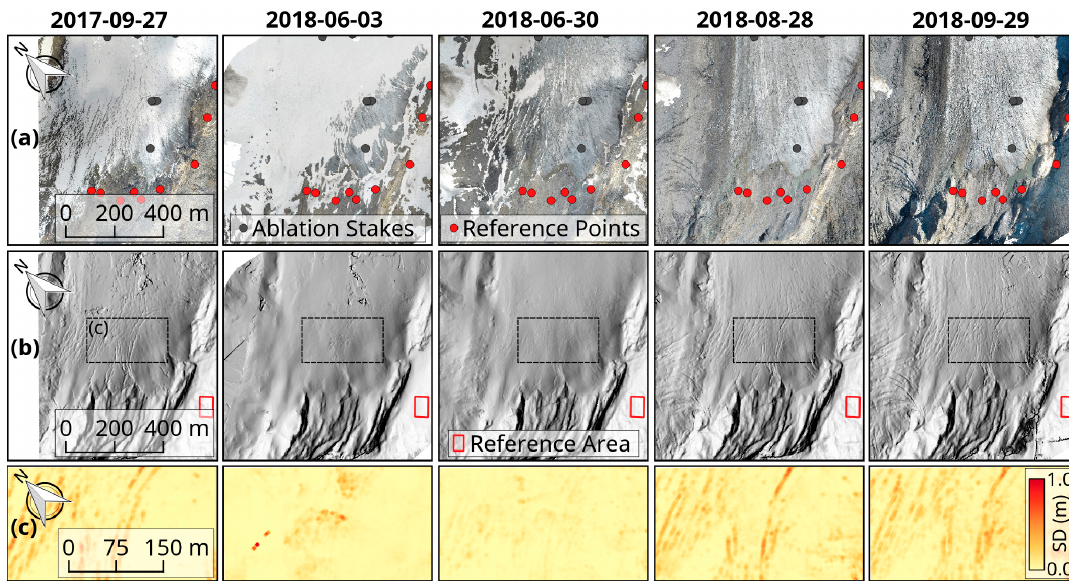
Figure 9. Spatial and temporal changes of the studied glacier surface. ( a ) Orthophotos (5 cm pixel resolution) of the tongue of the Kanderfirn generated with OpenDroneMap using images from nine UAV surveys performed on five di ff erent days in 2017 and 2018. ( b ) OpenDroneMap DSMs (25 cm pixel resolution) from the same days. ( c ) The variation of the surface roughness (here defined as standard deviation of the detrended DSM within a 5.25 × 5.25 m moving window) of the glacier tongue over the ablation season.